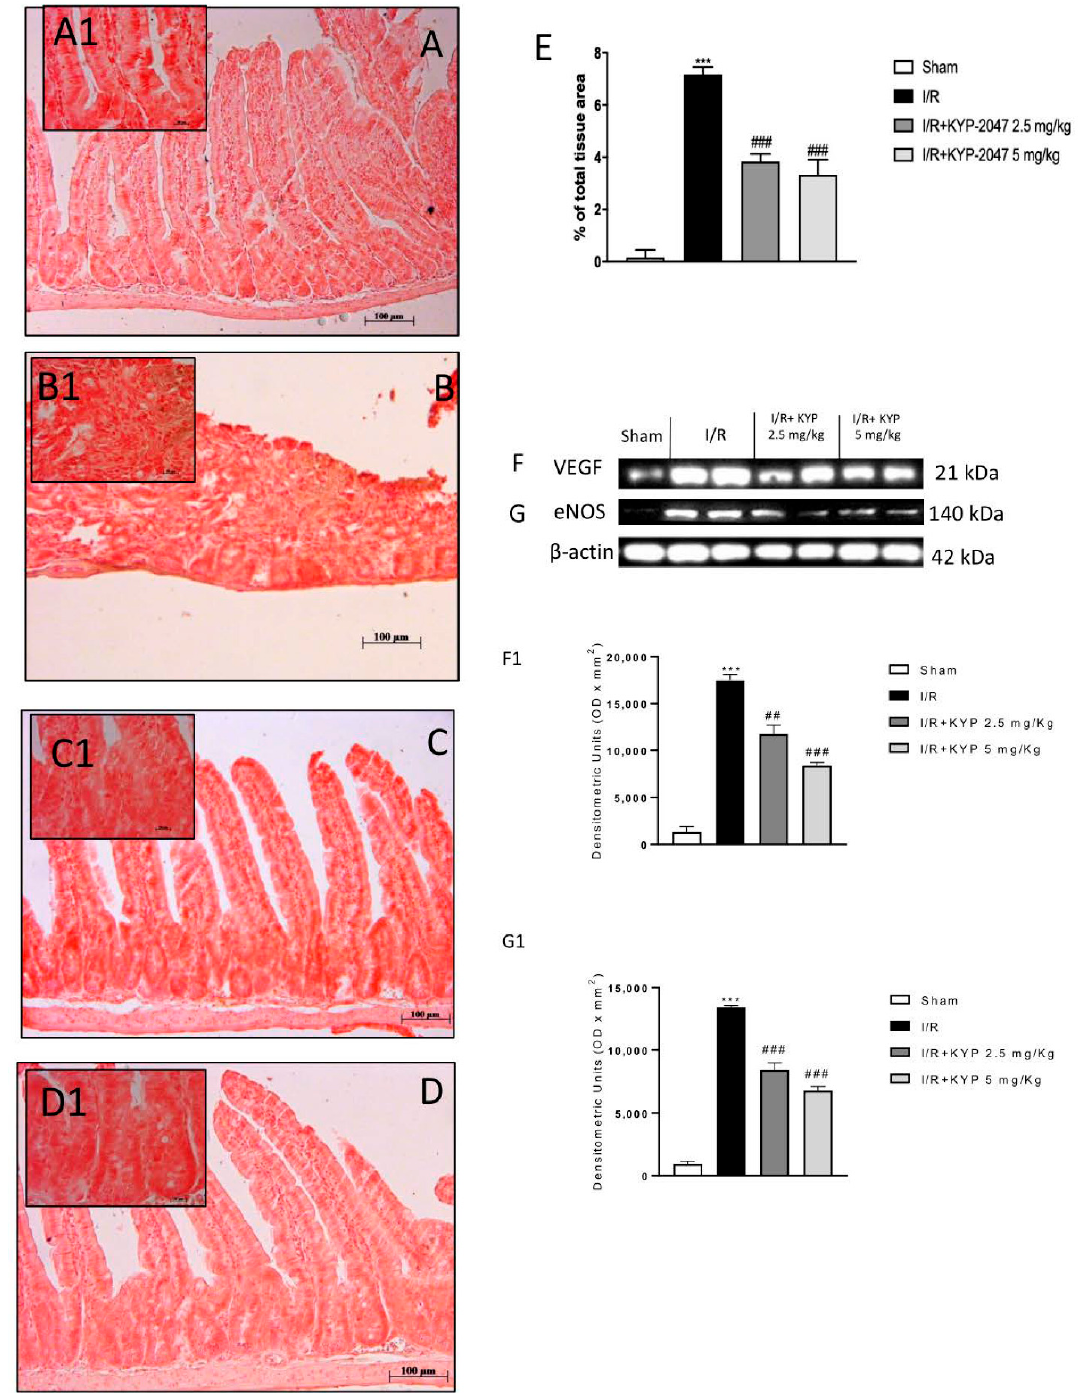
Figure 4. Effect of KYP-2047 on angiogenesis pathway. ( A ) No VEGF immunoreactivity was showed in control intestines. ( A1 ) 20 × magnification panel A. ( B ) Increased VEGF cell positivity was observed in IRI intestine. ( B1 ) 20 × magnification panel B. ( C , D ) The degree of positive staining for VEGF was markedly reduced in tissue sections after KYP-2047 2.5 mg/kg and 5 mg/kg treatments. ( C1 , D1 ) 20 × magnification panel C and D, respectively ( E ) Western blot analysis for VEGF. ( F ) Western blot analysis for eNOS showed increased expression levels in the IRI group. KYP-2047 2.5 mg/kg and 5 mg/kg treatments restored of eNOS levels was observed. ( F1 ) Densitometric analysis referred to blot in panel F. ( G , G1 ). Data are representative of at least three independent experiments. One-way ANOVA test *** p < 0.001 vs. sham; ## p < 0.01 vs. IRI; ### p < 0.001 vs.